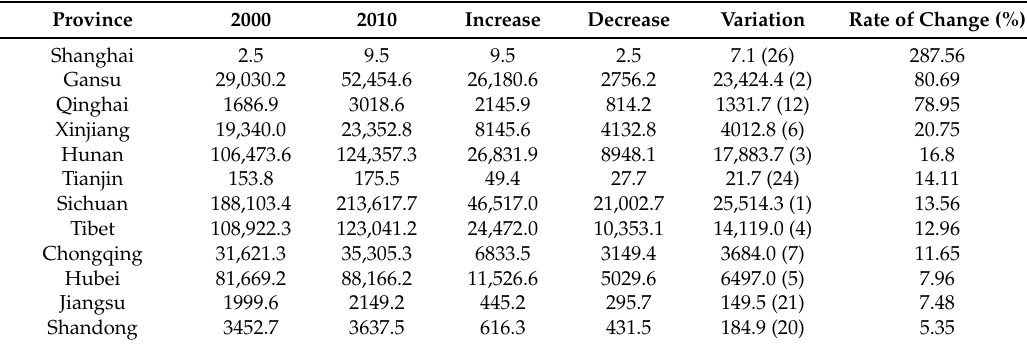
Table 3. Provincial changes in forest area in China, 2000–2010 (km 2